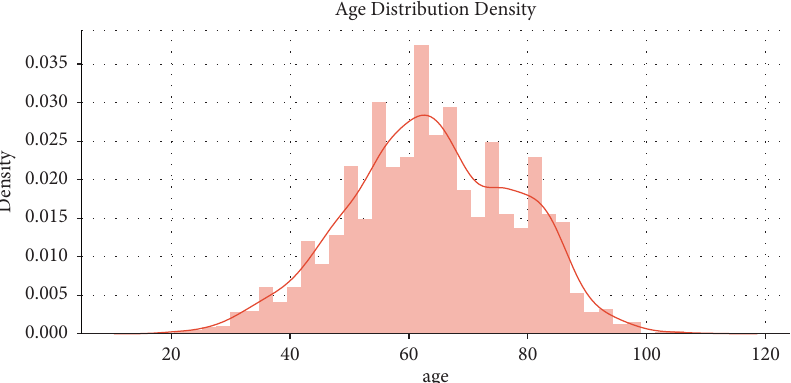
Figure 2: Age distribution density histogram.